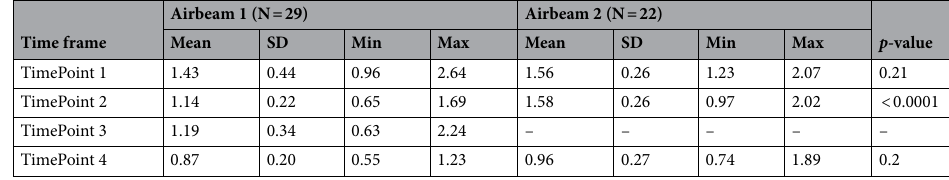
Table 1. Descriptive characterization of calibration coefficient measurements among two low-cost particle sensor types over a two-year timeframe, 2019–2021. SD standard